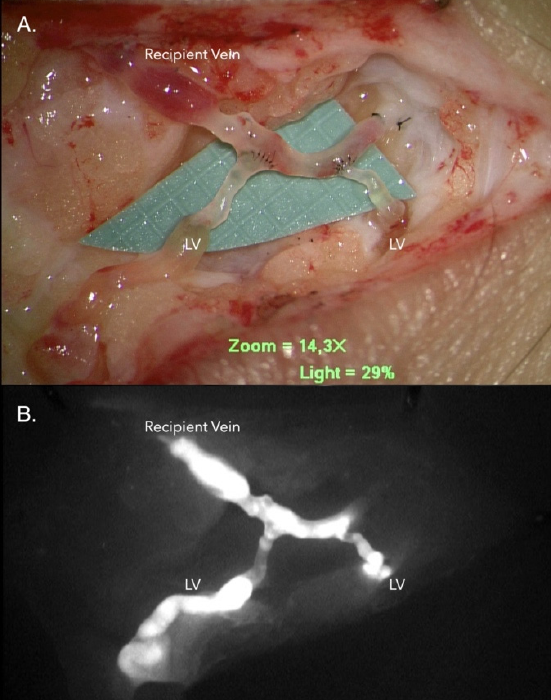
Figure 1. Lymphaticovenous anastomosis (LVA). ( A ) Two lymphatic vessels with diameter 0.7 mm and 0.5 mm were anastomosed to a recipient vein in an end-to-side orientation with 11-0 nylon suture. ( B ) The lumen of the recipient vein became enhanced under near-infrared lymphography. The indocyanine green (ICG)-containing lymph has flowed from the lymphatic vessel into the recipient vein, indicating good antegrade lymphatic flow. Note: the background grid is 1 * 1 mm 2 .